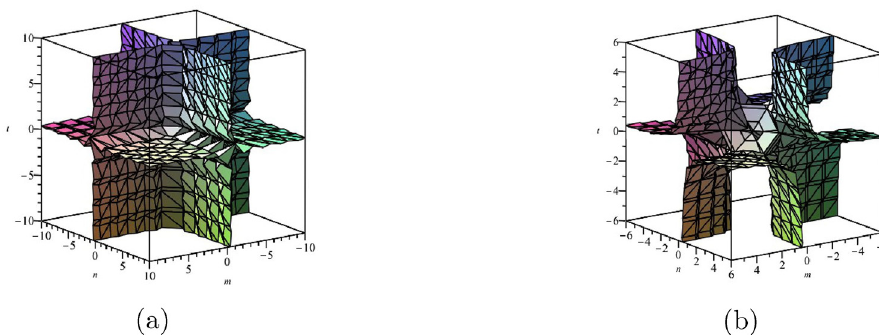
Figure 3: The ev - degree - based indices: ( a ) the Zagreb index and ( b ) the Randic index.